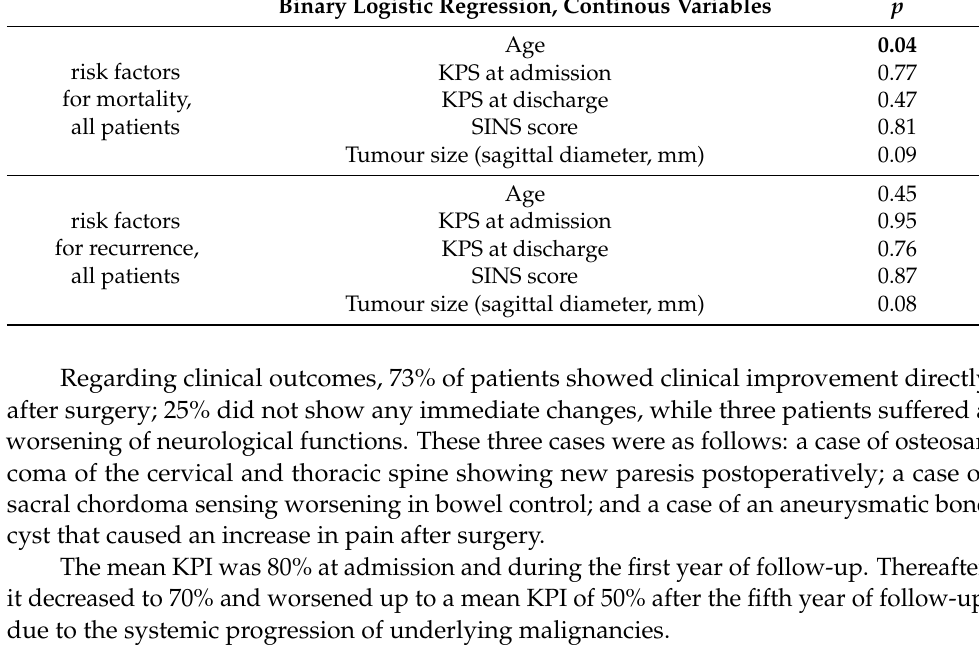
Table 3. Binary logistic regression analysis of risk factors for mortality and recurrence for all patients. Binary Logistic Regression, Continous